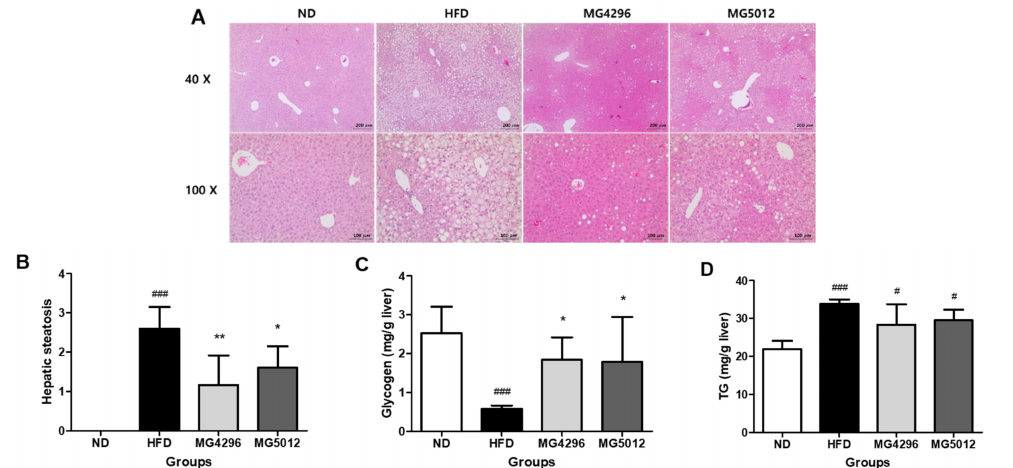
Figure 5. Histological changes in liver tissue of HFD-induced T2DM mice. ( A ) Representative photographs of hematoxylin and eosin (H&E)-stained sections of liver tissues (40 × and 100 × magnification), ( B ) Hepatic steatosis score, ( C ) Glycogen content, ( D ) Triglyceride (TG) content. Results are presented as mean ± SD ( n = 6). # p < 0.05, ### p < 0.001 vs. ND group. * p < 0.05, ** p < 0.01 vs. HFD group. ND; normal diet, HFD; high-fat diet.